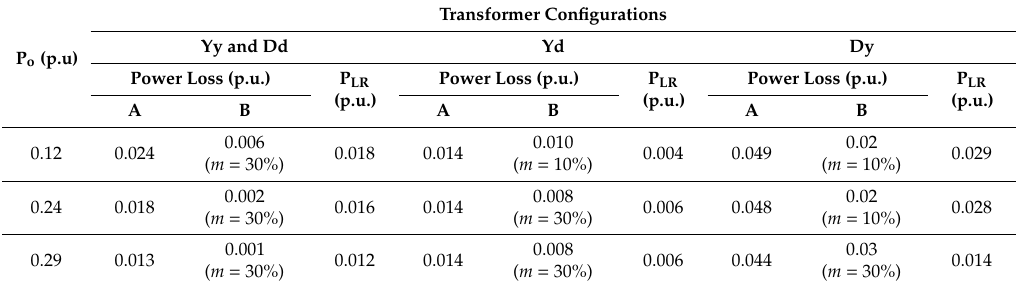
Power loss reduction with continuous and intermittent operation in di ff erent transformer